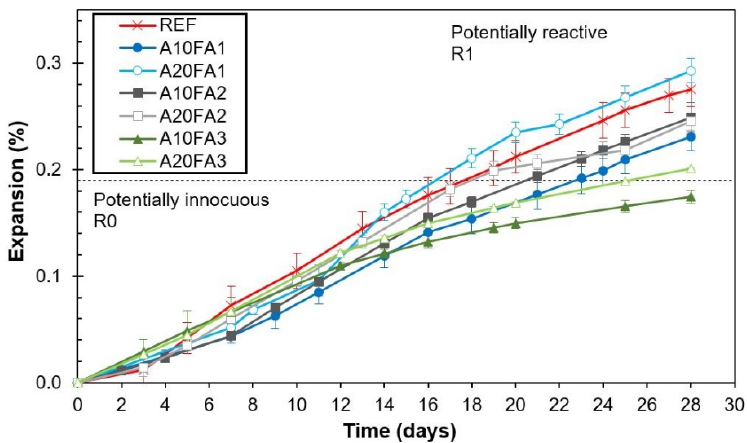
Figure 4. Expansion of the mortars, containing the fine of origin A, during the accelerated test for evaluation of the alkali- aggregate reaction (AAR) and the classification ranges.